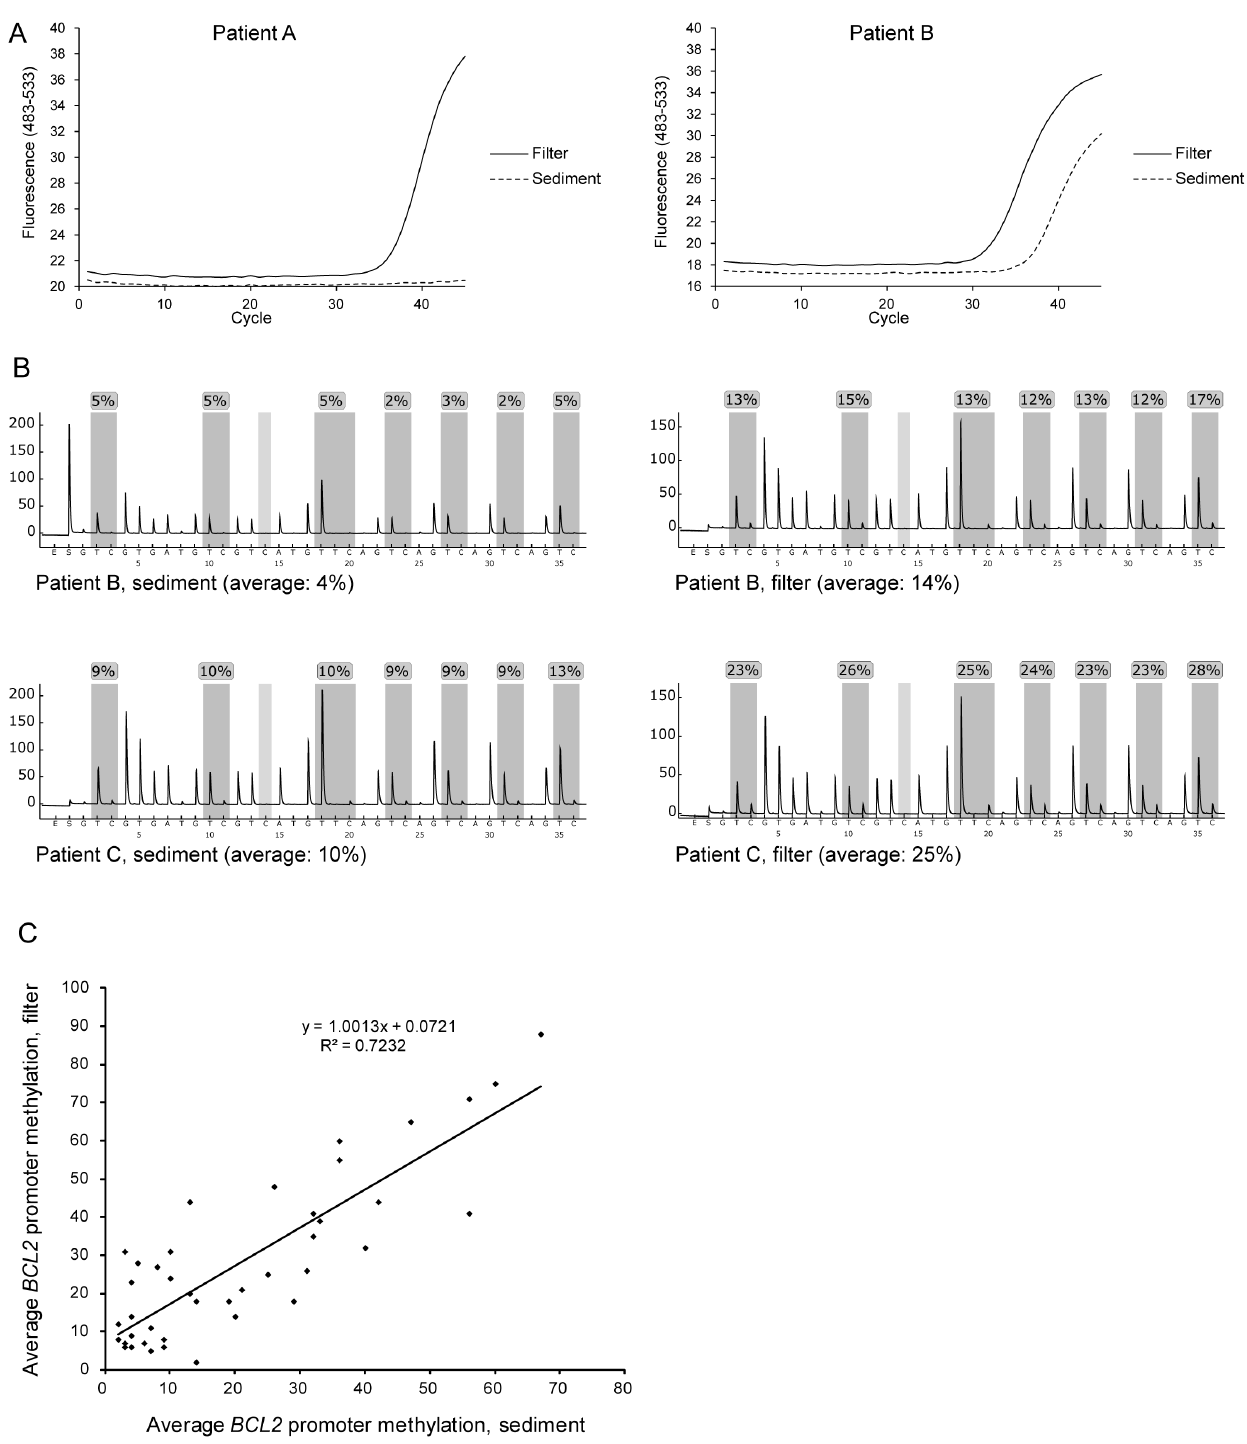
Figure 3. Analysis of tumor-derived DNA in paired urine samples (sediment and filter) from bladder cancer patients. ( A ) Examples of MethyLight analysis of BCL2 promoter CpG island methylation. In patient A, amplification is seen in the filter sample but not in the sediment sample. In patient B, amplification is seen in both samples; however with a higher Ct value for the sediment sample. ( B ) Examples of BCL2 promoter CpG island methylation analysis by pyrosequencing in paired samples. Average methylation level is calculated for the seven individual CpG sites assayed (indicated by dark grey shading). The average methylation level in the sediment sample from patient B was below the background signal for pyrosequencing, in contrast to the MethyLight assay ( A ), showing the difference in analytical sensitivity between the two assays. ( C ) Average methylation levels for paired samples as determined by pyrosequencing. Shown are the results for cases where at least one of the paired samples showed signals above the background for pyrosequencing (N=42).